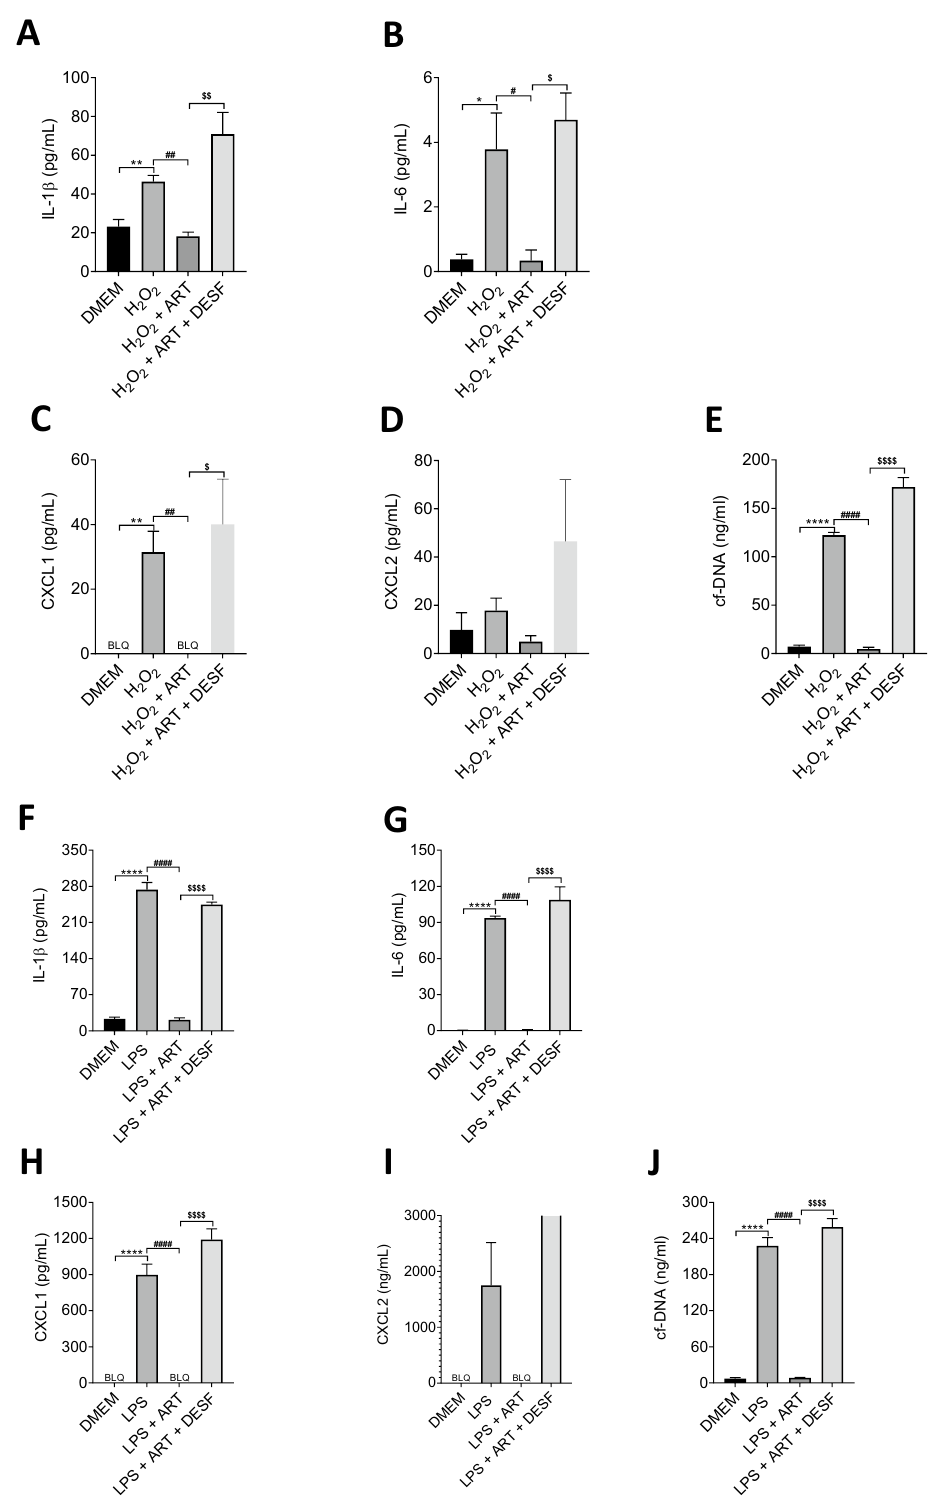
Figure 6. Artesunate directly suppresses cytokine and NET release in response to H 2 O 2 or LPS in vitro. Graphs show release of cyto/chemokines and NETs from isolated neutrophils after 4 h in culture. Black bar in all graphs represent the release from neutrophils in culture incubated with DMEM only. All other additions were made before the start of the incubation period, as follows: ( A – E ), bars show (from left): 10 μM H 2 O 2 ; 10 μM H 2 O 2 plus 10 μM artemisinin; 10 μM H 2 O 2 plus 10 μM artemisinin plus 50 μM desferioxamine; ( F – J ) LPS (10 ng/l); LPS plus artemisinin (10 μM); LPS plus 10 μM artemisinin plus 50 μM desferioxamine. BLQ, below limit of quantitation. Statistical analysis: *p < 0.05; **p < 0.01. ***p < 0.001, ****p < 0.0001 for comparison of H 2 O 2 or LPS with DMEM control; #p < 0.05; ##p < 0.01. ###p < 0.001, ####p < 0.0001 for comparison of H 2 O 2 or LPS with H 2 O 2 /LPS + Artemisinin; and $p < 0.05; $$p < 0.01. $$$p < 0.001, $$$$p < 0.0001 for comparison of H 2 O 2 or LPS + Artemisinin with H 2 O 2 or LPS + Artemisinin + Desferrioxamine (One-way ANOVA and Bonferroni post-hoc